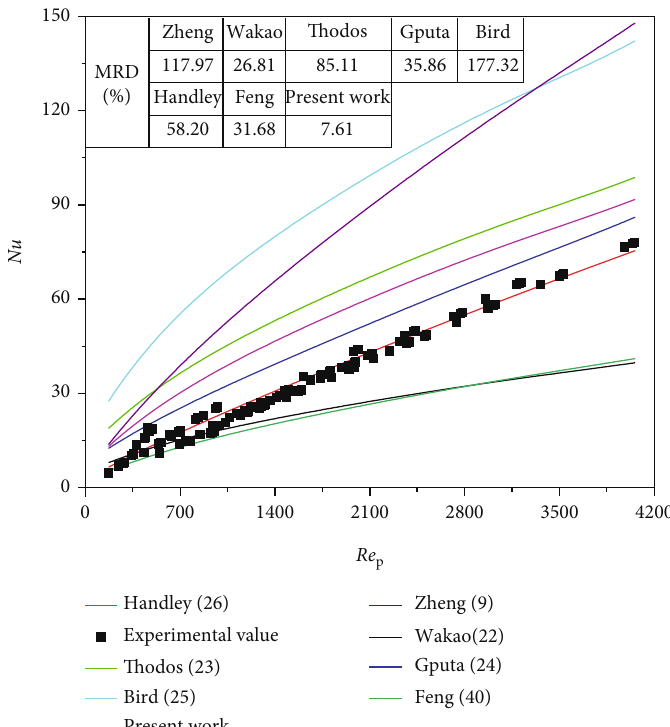
Figure 19: Comparison between the measured value of the Nusselt number Nu and predicted value of this work and other